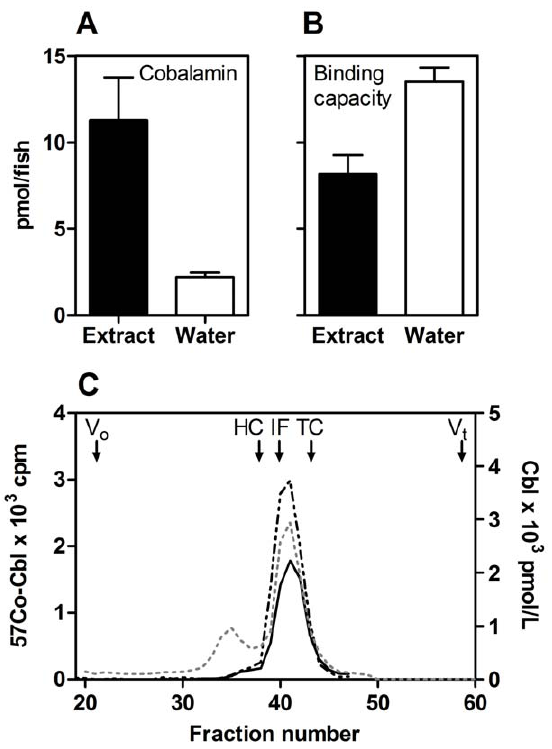
Figure 1. Secretion of Zebrafish Cobalamin-binding Protein to the Ambient Water. Five zebrafish were kept in 100 ml tapped water for six hours and content of cobalamin (A) and unsaturated cobalamin binding capacity (B) in the zebrafish ambient water was measured and compared to the values found in zebrafish protein extracts. Mean and SEM of three independent studies are indicated. (C) Size exclusion chromatography of the cobalamin binders found in zebrafish protein extract (full drawn line) and in collected zebrafish-ambient-water (black dashed line) measured as unsaturated cobalamin binding capacity, 57 [Co]-cobalamin (57Co-Cbl) (left Y-axis), and as amount of protein- bound cobalamin (Cbl) in the protein extract (grey dashed line) (right Y- axis). X-axis indicates the fraction number. Elution volume for void volume (V 0 ), human HC, IF, TC, and total volume (V t ) are shown by arrows.